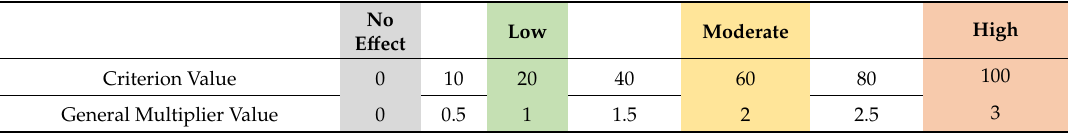
Table 8. Example evaluation for the e ff ects on landscape and vegetation fire e ff ects category. The scale of criteria values ranges from 0 (no e ff ect) to 100 (high e ff ect), while for the general multiplier value from 0 (no e ff ect) to 3 (high e ff ect). Light gray: Choices with no e ff ect; Dark gray: N / a, denotes a non-applicable or not available selection; Green: Choices with low e ff ect; Yellow: Choices with moderate e ff ect; Red: Choices with high e ff